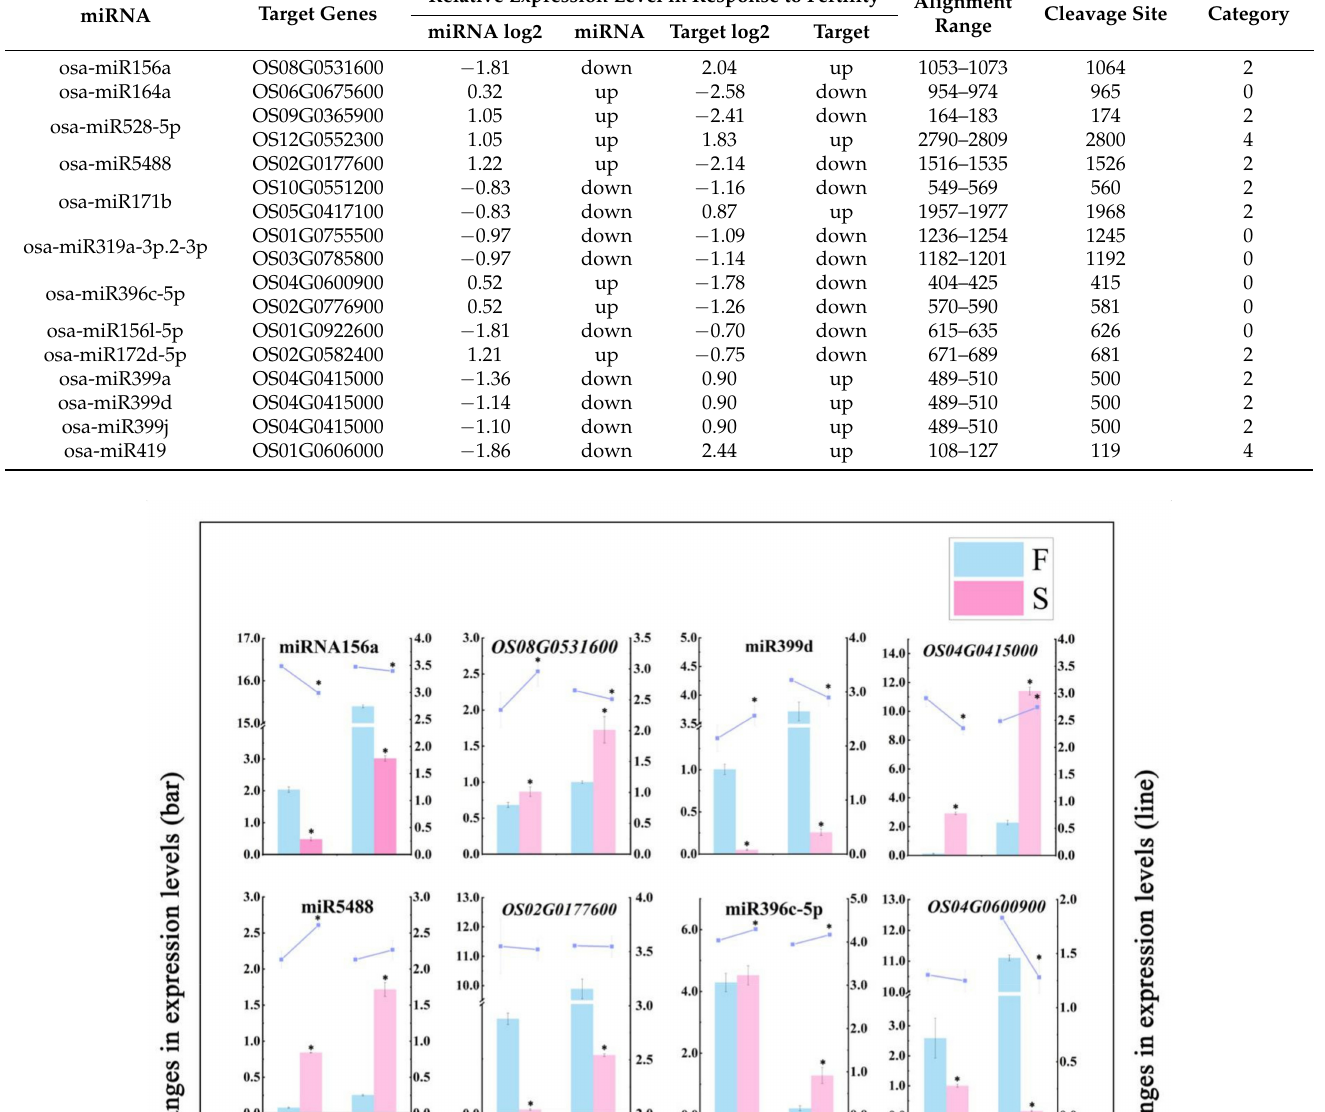
Table 4. The regulatory miRNA–mRNA interaction pairs in PA64S(S) compared with PA64S(F). miRNA